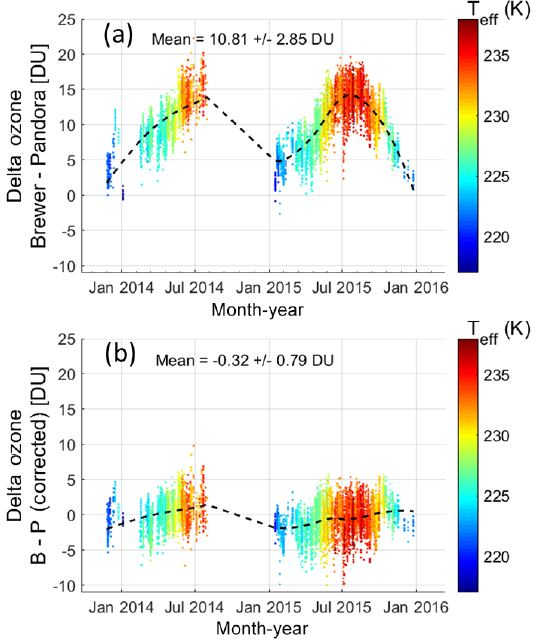
Figure 5. Time series of Brewer no. 14–Pandora no. 103 TCO difference colour-coded by ozone effective temperature (see Eq. 1): (a) before applying the temperature dependence correc- tion and (b) after applying the correction. The dashed lines are LOWESS(0.5) fits.